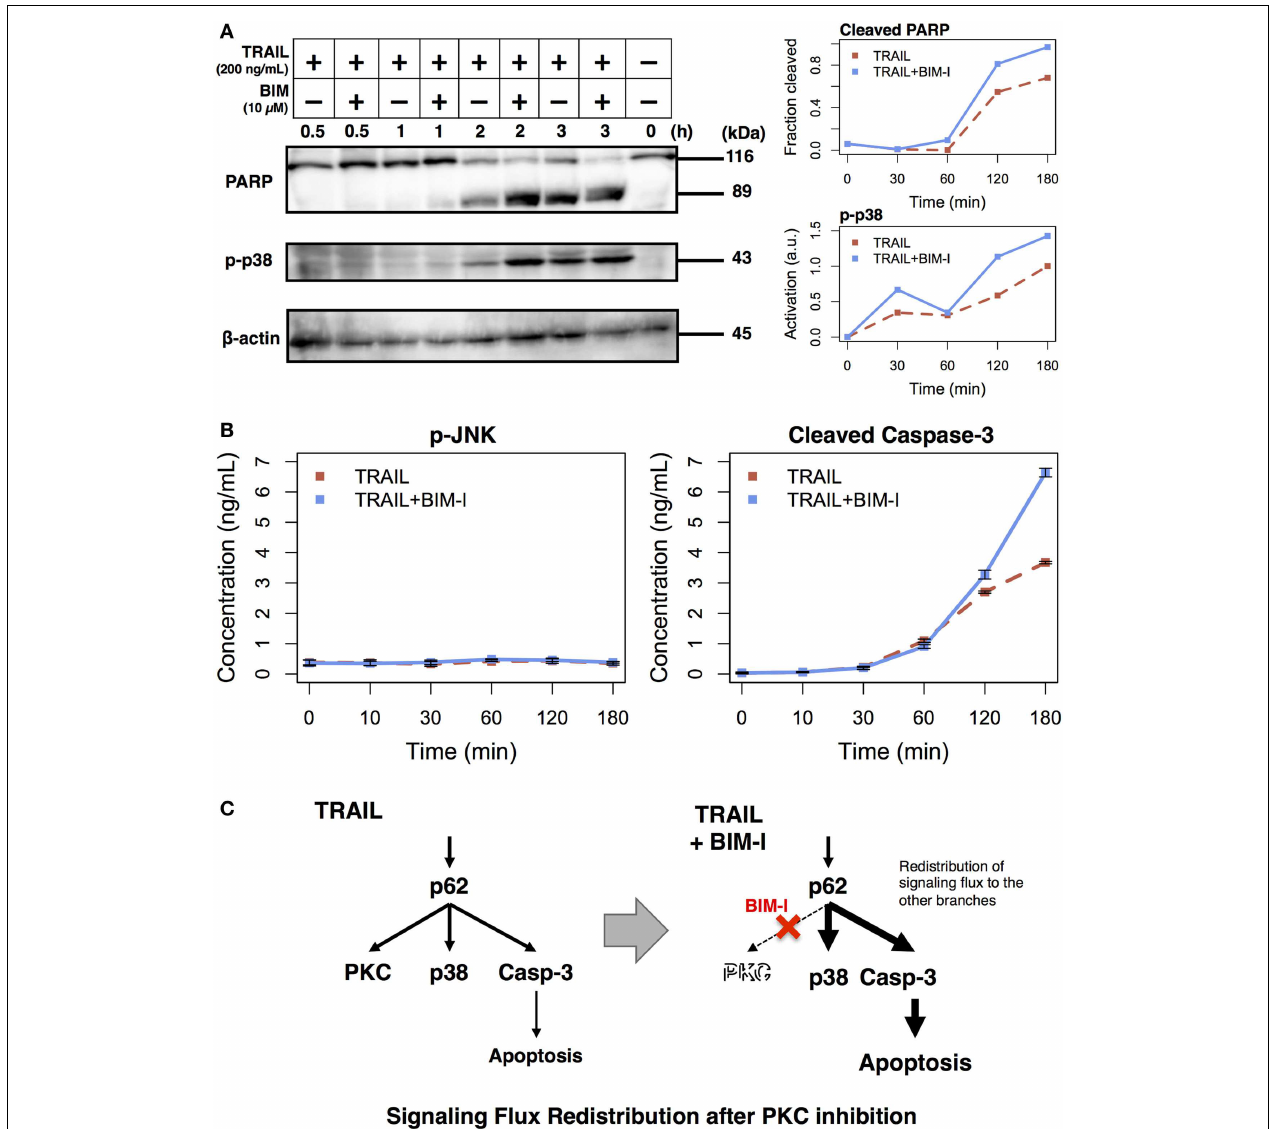
without BIM-I) using ImageJ (http://imagej.net). (B) Phosphorylation of JNK and levels of cleaved caspase-3 protein were measured by ELISA at 0, 10, 30, 60, 120, and 180min afterTRAIL stimulation (200ng/mL) of HT1080 cells in the absence or presence of BIM-I (10 µ M). Error bars indicate mean values ± SD for n = 3 independent experiments. (C) Schematic representing the mechanism of signaling flux redistribution at p62 pathway junction toward p38 and caspase-3 signaling branches when PKC is